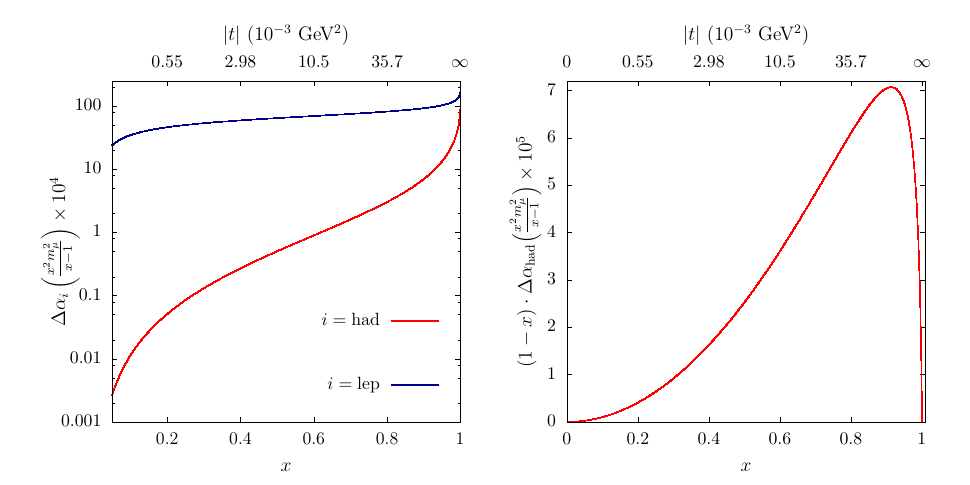
Figure 1. Left: ∆ α had [ t ( x )] × 10 4 (red) and, for comparison, ∆ α lep [ t ( x )] × 10 4 (blue), as a function of x and t (upper scale). Right: the integrand (1 − x ) ∆ α had [ t ( x )] × 10 5 as a function of x and t . The peak value is at x peak (cid:39) 0 . 914, corresponding to t peak (cid:39) − 0 . 108 GeV 2 .